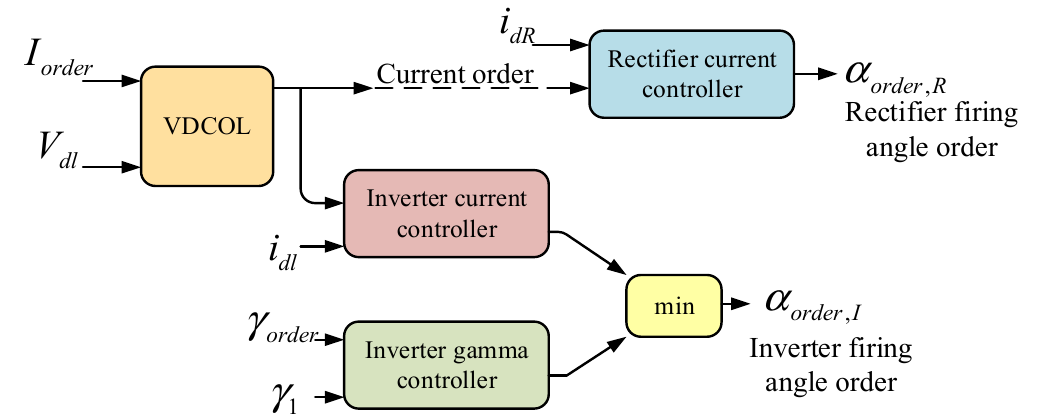
Figure 9. The operational flow diagram of the HVDC control scheme. Table 3. Comparative study of various control strategies of HVDC.